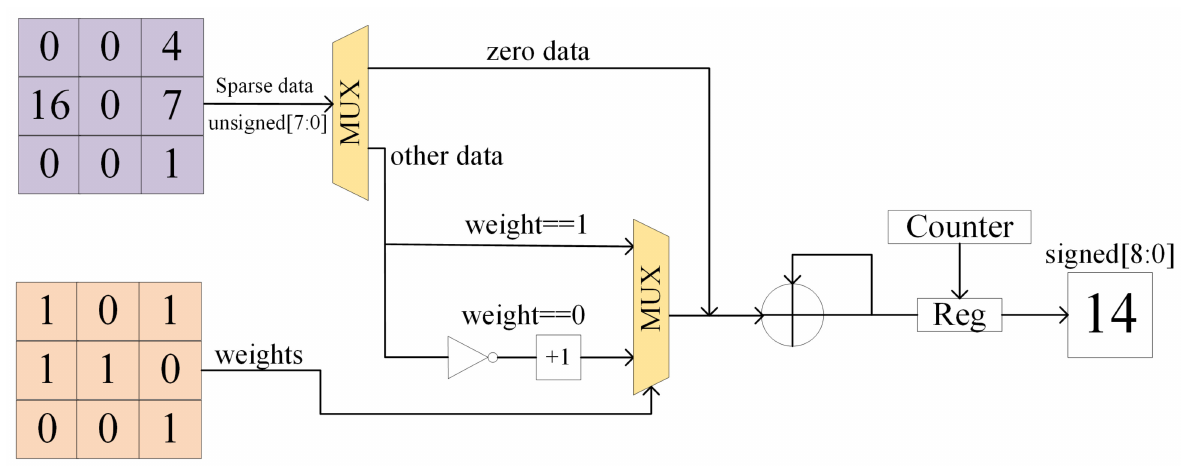
Figure 5. Binary convolution computational processing